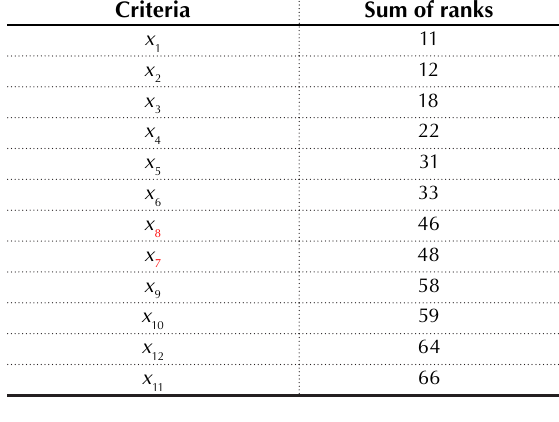
Table 2. Calculated matrix of